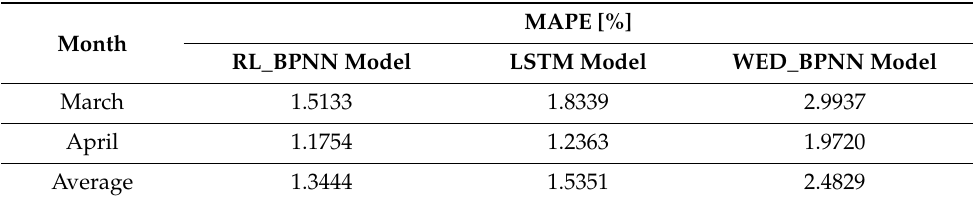
Figure 12. Mean absolute percentage error (MAPE) of the models for the simulation period. Table 6. MAPE of the models during March and April 2018.